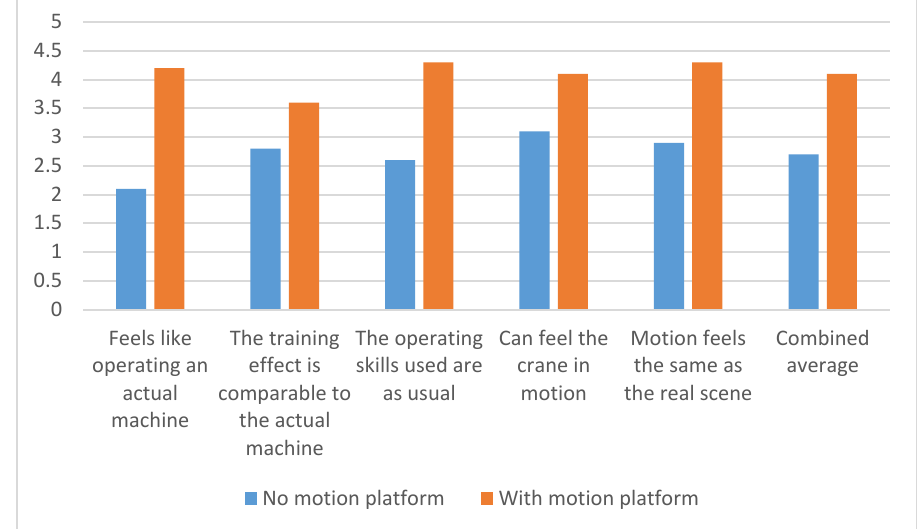
Figure 16. Column chart of controlled subjective evaluation test results.